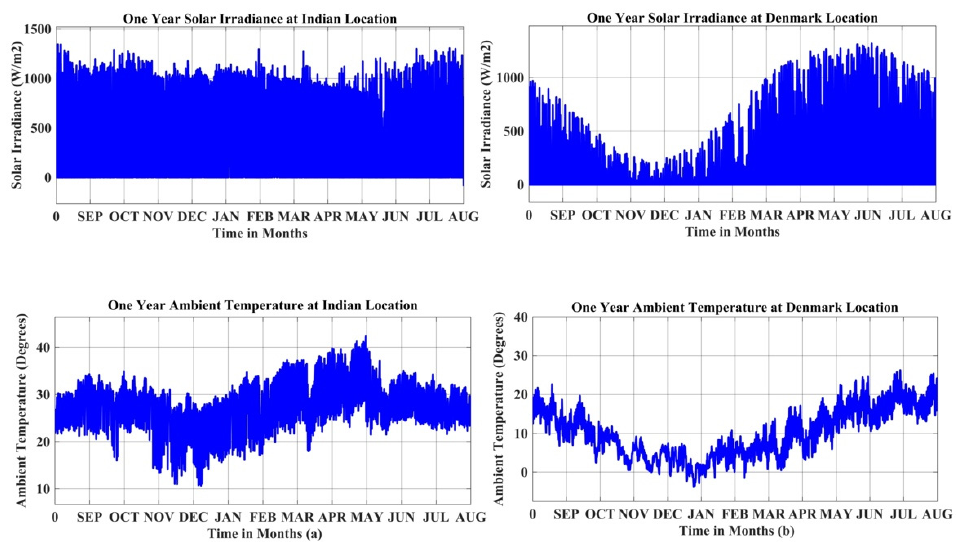
Figure 2. ( a ) Yearly MP data in the India location; ( b ) Yearly MP data in the Denmark location.